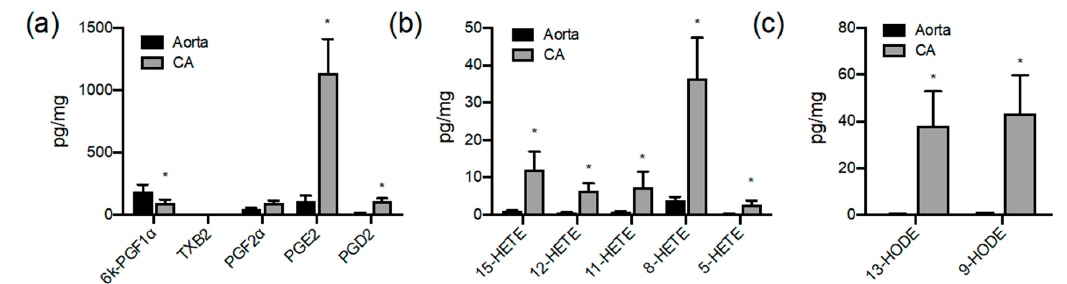
Figure 3. Comparison of aortic and coronary artery production of cyclooxygenase and ‘lipoxygenase’ oxylipin products. Figures show ( a ) cyclooxygenase, ( b ) ‘lipoxygenase’ products of arachidonic acid (HETEs) and ( c ) linoleic acid (HODEs) products released by pig aorta (black bars) and coronary artery (grey bars). Oxylipins accumulated in 24 h serum-free organ culture were measured by LC–MS / MS and expressed as pg / mg of wet tissue weight. Data represents organ culture from n = 3–4 separate animals. * indicates p < 0.05 between Aorta and CA.